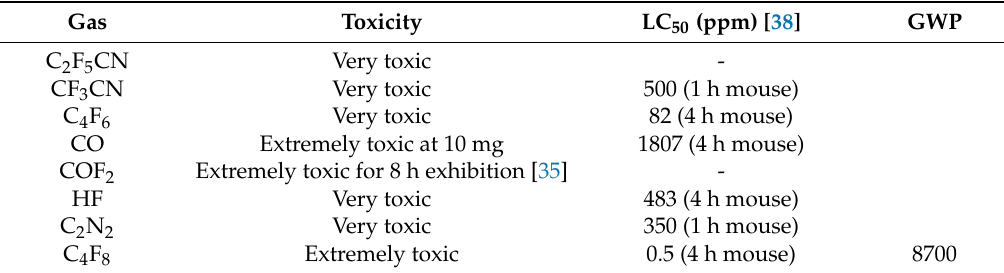
Table 14. Toxicity of degradation products of fluoronitriles